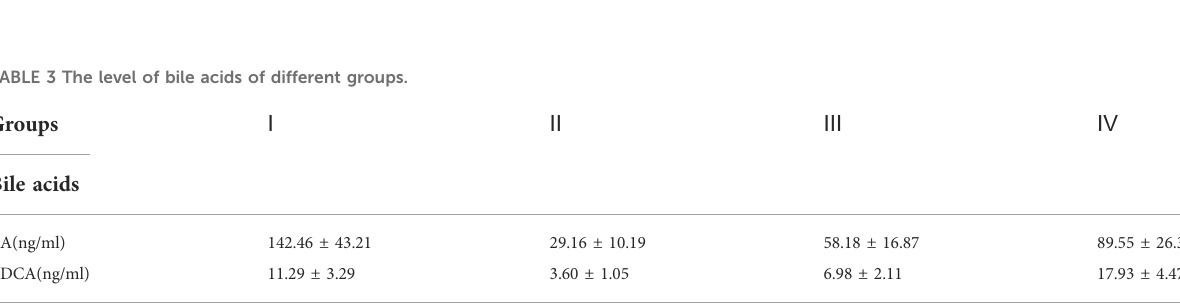
Ⅱ , 15.26 ± 2.81 ng/ml in group Ⅲ , 18.75 ± 4.53 ng/ml in group Ⅳ and 20.66 ± 4.43 ng/ml in group Ⅰ . The differences between groups Ⅱ and Ⅲ and groups Ⅳ and Ⅰ were not statistically